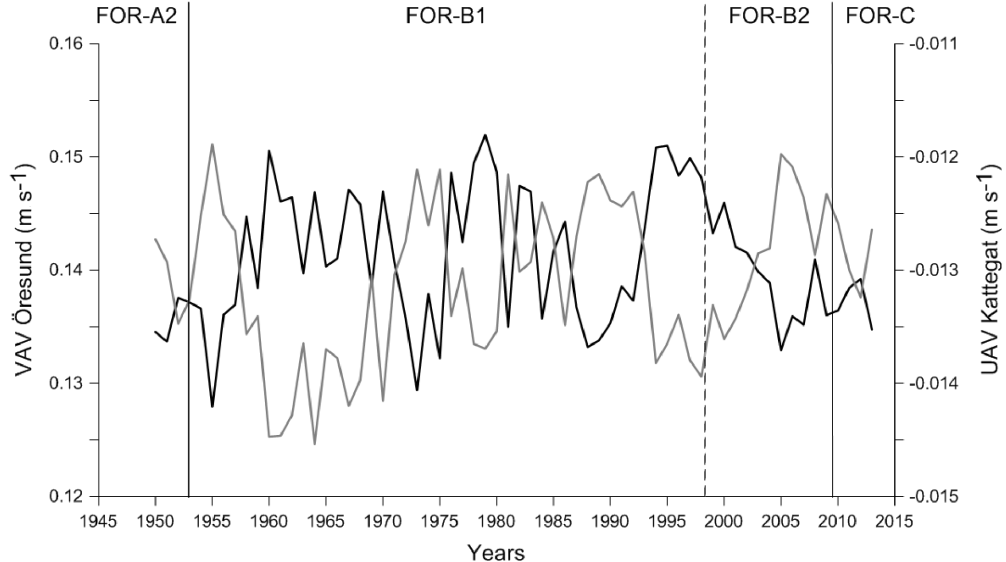
Figure 8. South–north flow (VAV) in the Öresund (dark line) and west–east flow (UAV) in the Kattegat (light line) between 1950 and 2013. Foraminiferal zones